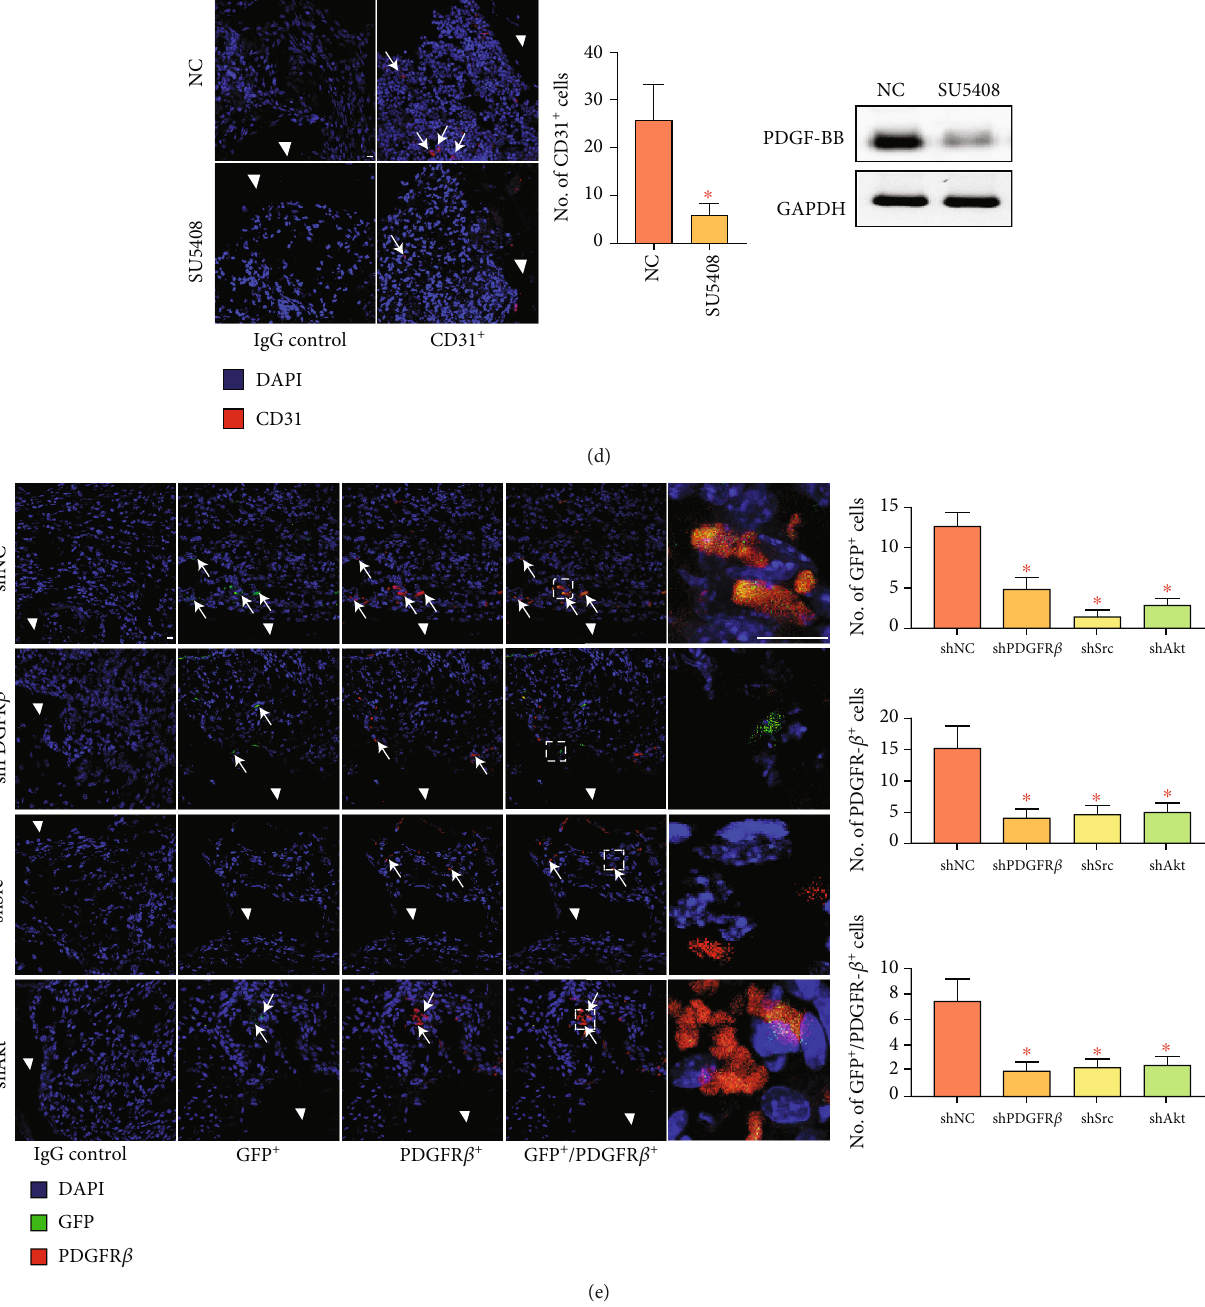
Figure 4: Data of in vivo experiments. (a) Fluorescence-activated cell sorting of CD31 + cells within implants at postoperative days 1, 3, and 7. The percent of CD31 + cells migrated cells was shown as a bar graph. (b) Gene and protein expression of PDGF-BB in sorted CD31 + cells. Data were shown as bar graphs. (c) A positive correlation lay between the ratio of CD31 + cells and the protein level of PDGF-BB (Pearson ’ s correlation coe ffi cient R =0.926, P < 0 : 05 ). (d) Representative images of in fi ltrated CD31 + cells and PDGF-BB levels within implants. The quantitative comparison was detailed as bar graphs ( n =5). (e) Representative images of homed MSCs within implants. The quantitative comparisons were detailed as bar graphs ( n =5). Scale bars, 10 μ m. ∗ P < 0 : 05 . Triangles, implants. Arrows, staining positive cells. shPDGFR β : short hairpin RNA targeting pdgfrb ; shSrc: shRNA targeting src ; shAkt: shRNA targeting akt